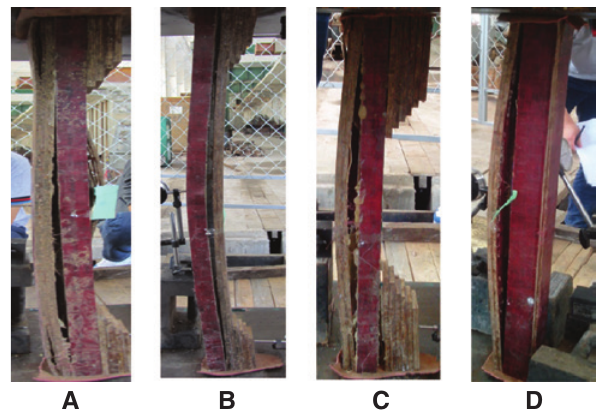
Figure 11: Damage from glue failure of the matrix in the middle of the column.